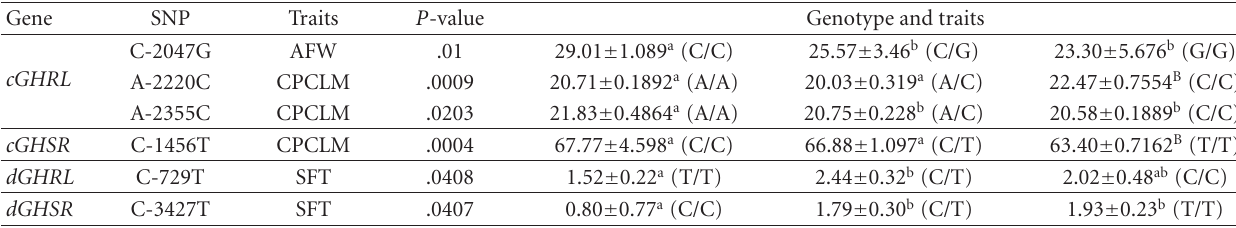
Table 4: E ff ects of SNPs on fatty traits in chicken and